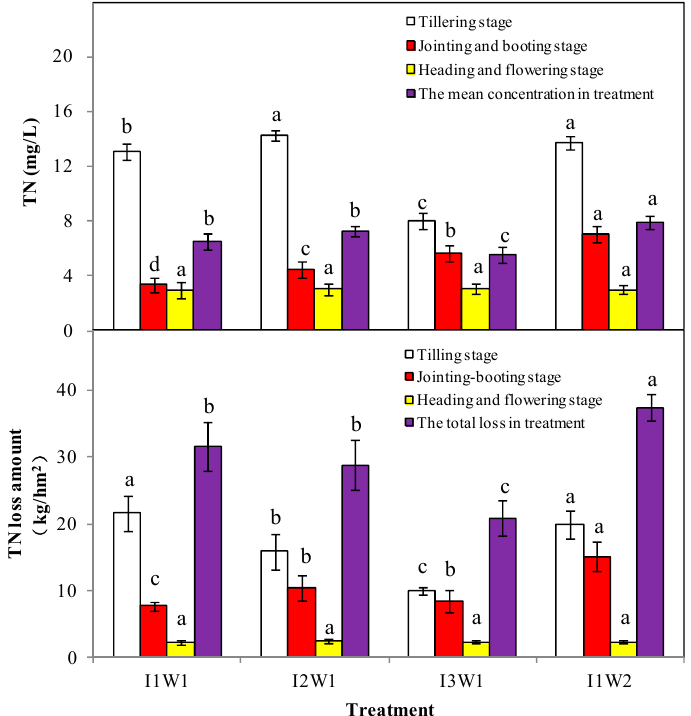
Figure 2. Total nitrogen (TN) losses for surface discharge in different irrigation treatments. I1W1 represents shallow–frequent irrigation with aquaculture wastewater; I2W1 represents shallow–wet irrigation with aquaculture wastewater; I3W1 represents flooding irrigation with aquaculture wastewater; I1W2 represents shallow–frequent irrigation with fresh water. Data are mean ± SD ( n = 4). The different letters on the tops of columns indicate significant differences among treatments at 5% according to Duncan’s multiple range test.